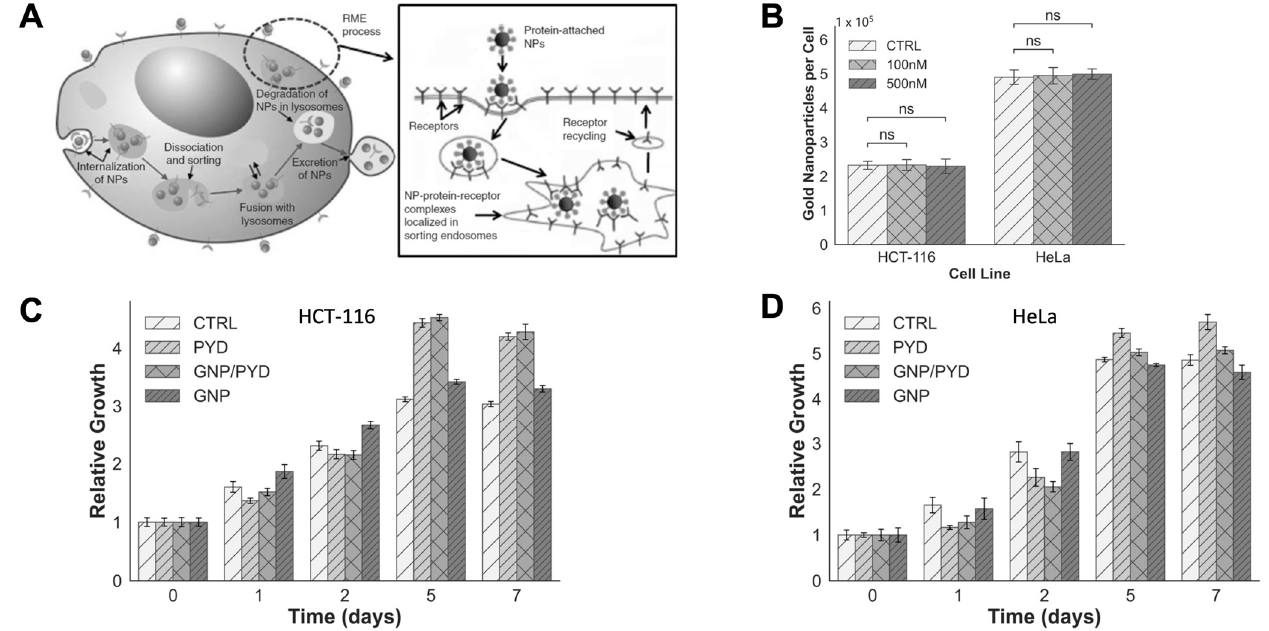
Figure 4. Cellular uptake and transport of GNPs. ( A ) Schematic diagram illustrating the endo-lyso path of GNPs within a cell, and inset figure further illustrates the endocytosis process. ( B ) Comparison of the cellular uptake of GNPs in the presence and absence of PYD. ( C , D ) Relative growth in the presence of GNPs and 500 nM of PYD for HCT-116 and HeLa, respectively. Cells were dosed with GNPs at concentration of 7.5 µg/mL. “ns” indicates no significance.